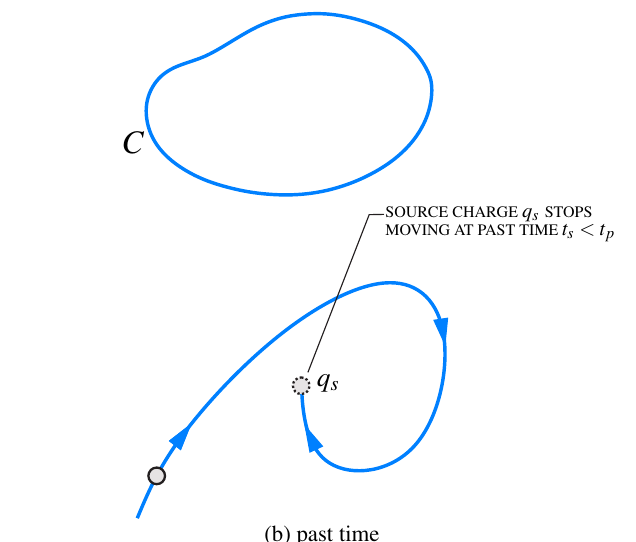
d r = 0. In ( b ) the source charge q s is moving E c C · (cid:72)